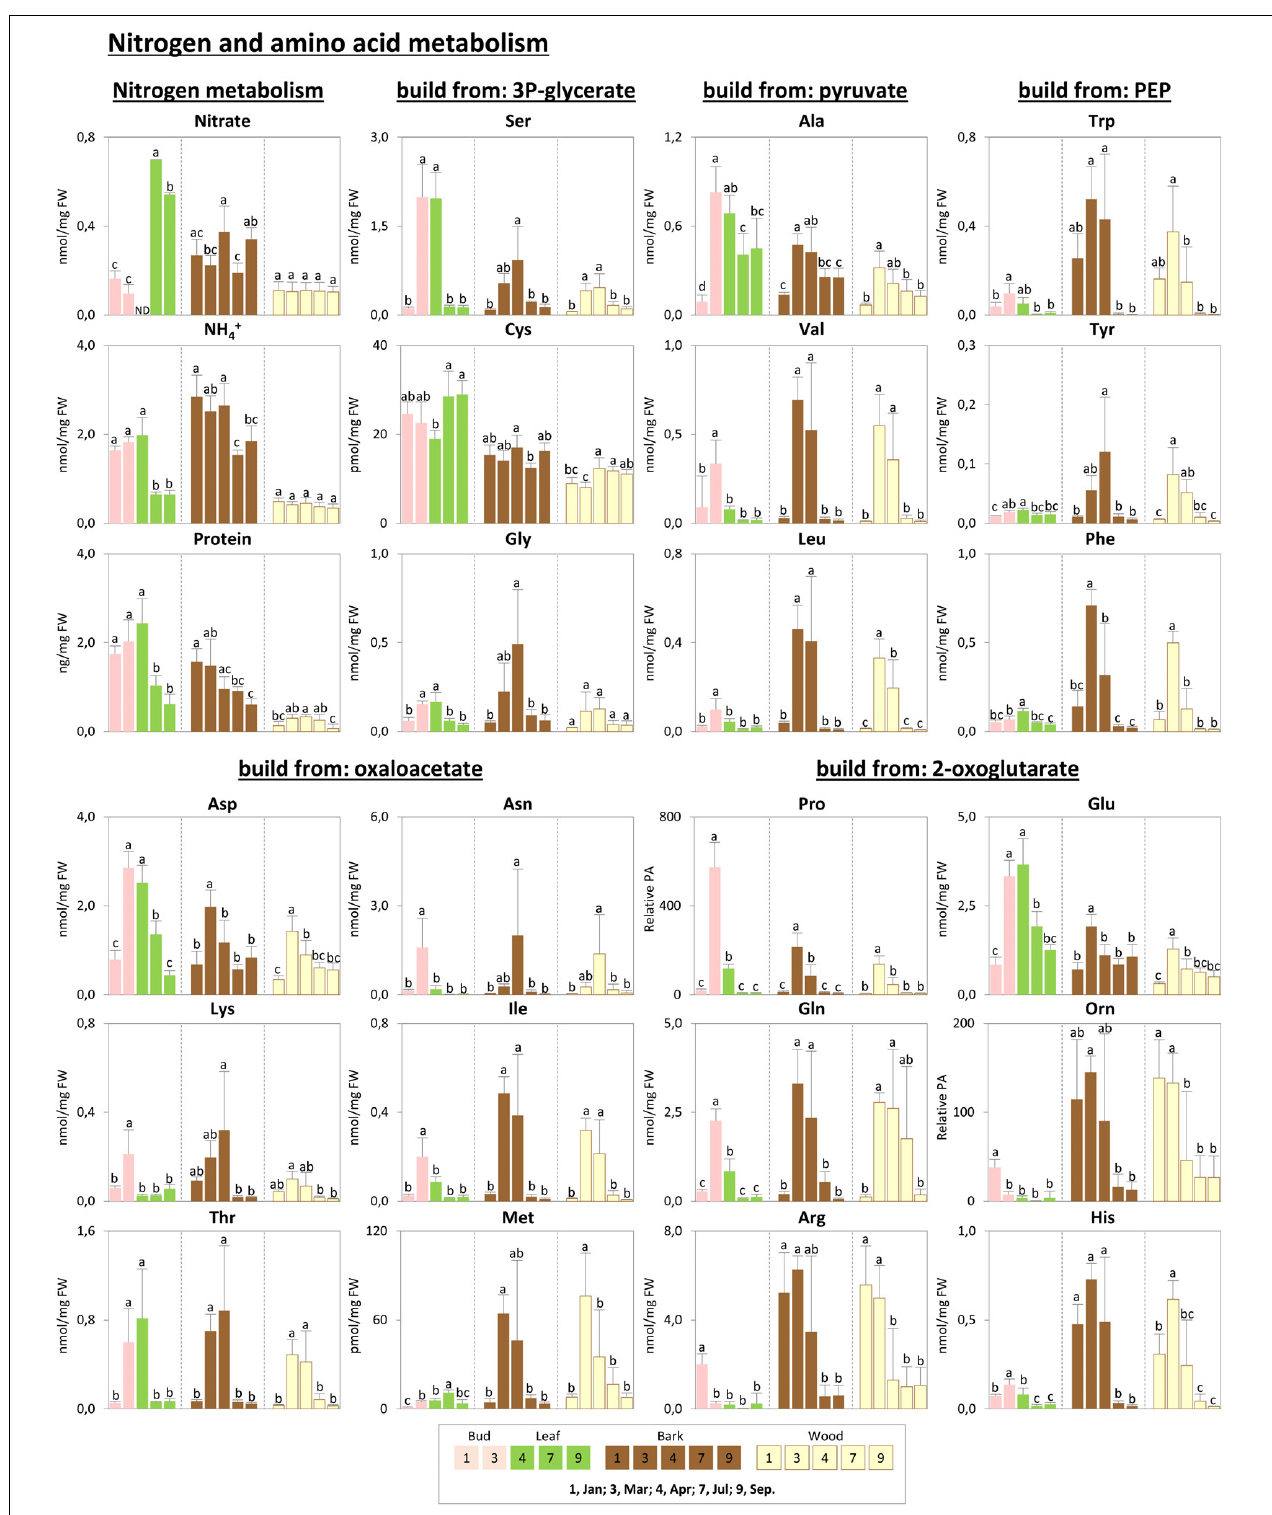
FIGURE 5 | Metabolic changes in nitrogen, protein, and amino acid metabolism. Changes of the selected metabolites in nitrogen, protein, and amino acid metabolism in poplar during annual growth. Data represent mean values of five biological replicates in each organ/tissue for each season. Error bars represent SD. Different letters represent statistically significant differences ( P < 0.05) between seasons in each organ/tissue using Tukey’s test ( Supplementary Table S1 ). Relative PA, relative peak area; 3P-glycerate, 3-phosphate-glycerate; PEP, phosphoenolpyruvate; Orn, ornithine; ND, under detection limit.